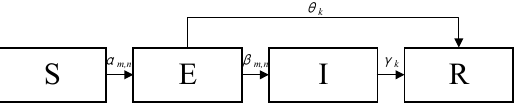
Figure 3. Information dissemination dynamics model of UEN.